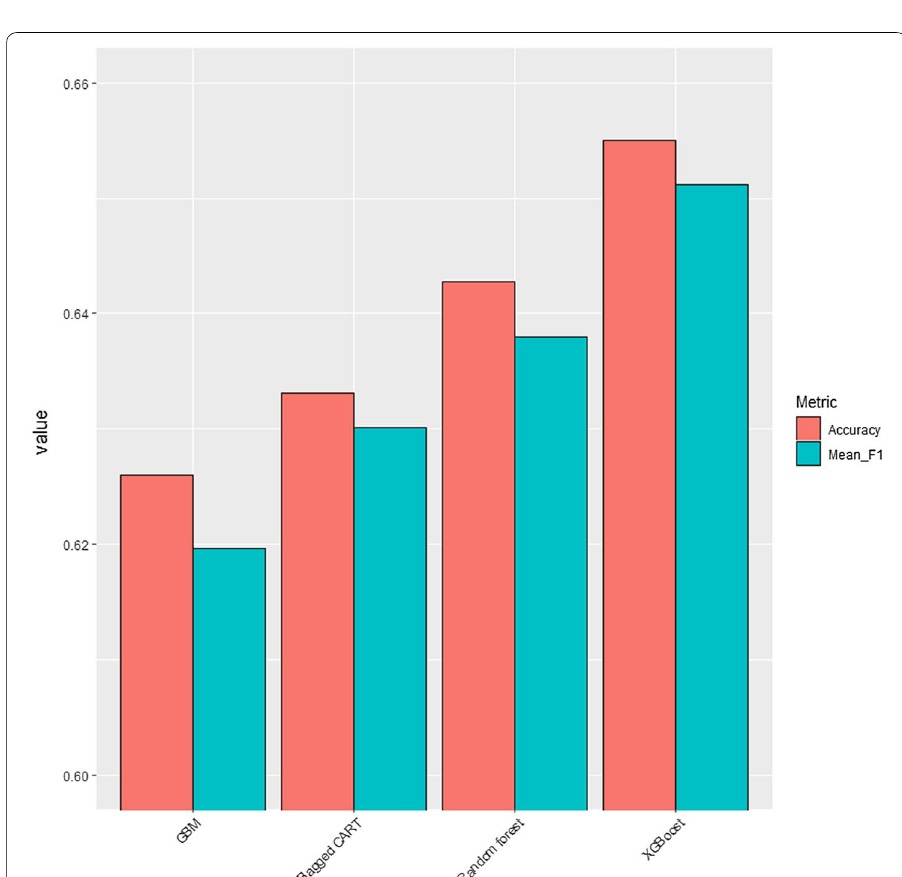
Fig. 5 Results of classification algorithms for age